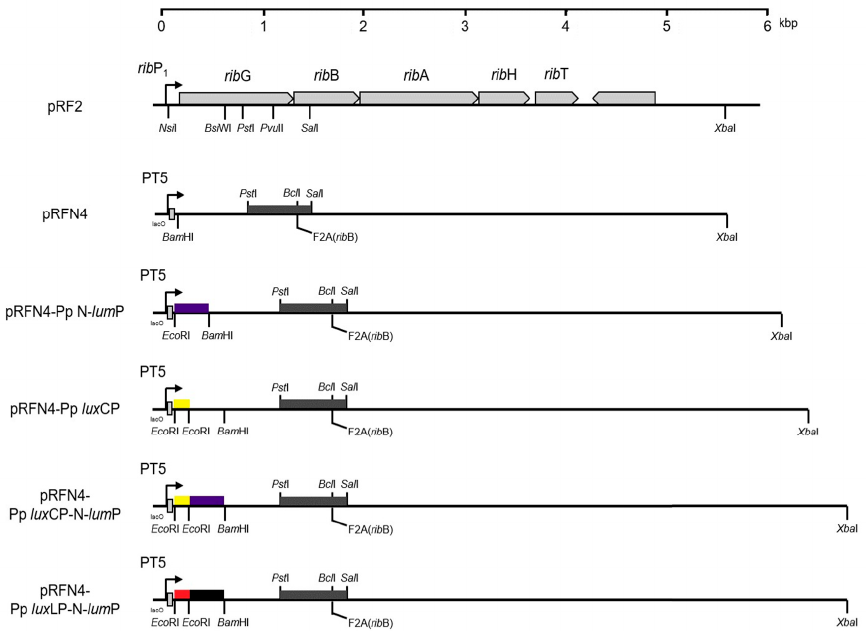
Figure 5. Gene map of recombinant plasmids with inserted P. phosphoreum lux genes. Recombinant pRFN4 plasmids used in this study: pRFN4, pRFN4-Pp N- lum P, pRFN4-Pp lux CP, pRFN4-Pp lux CP-N- lum P, and pRFN4-Pp lux LP-N- lum P plasmids. The nomenclature of riboflavin biosynthetic genes of B. subtilis differs from other species. Therefore, rib E in pRF2 and pRFN4 is the gene coding for riboflavin synthase in B. subtilis [5]. In pRFN4, the rib E gene coding for Phe 2 in riboflavin synthase was replaced with Ala for overproduction of lumazine (F2A in rib B) [13].